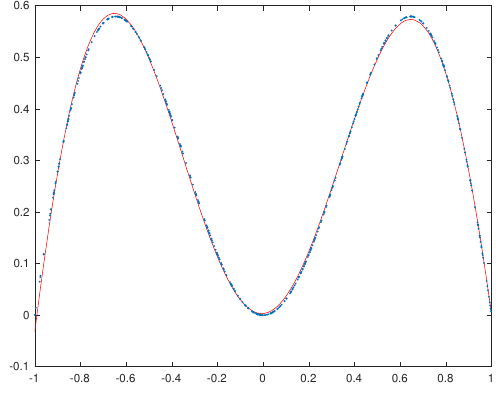
Figure 1. RPSGLA ( s = 5) with noiseless data after 100